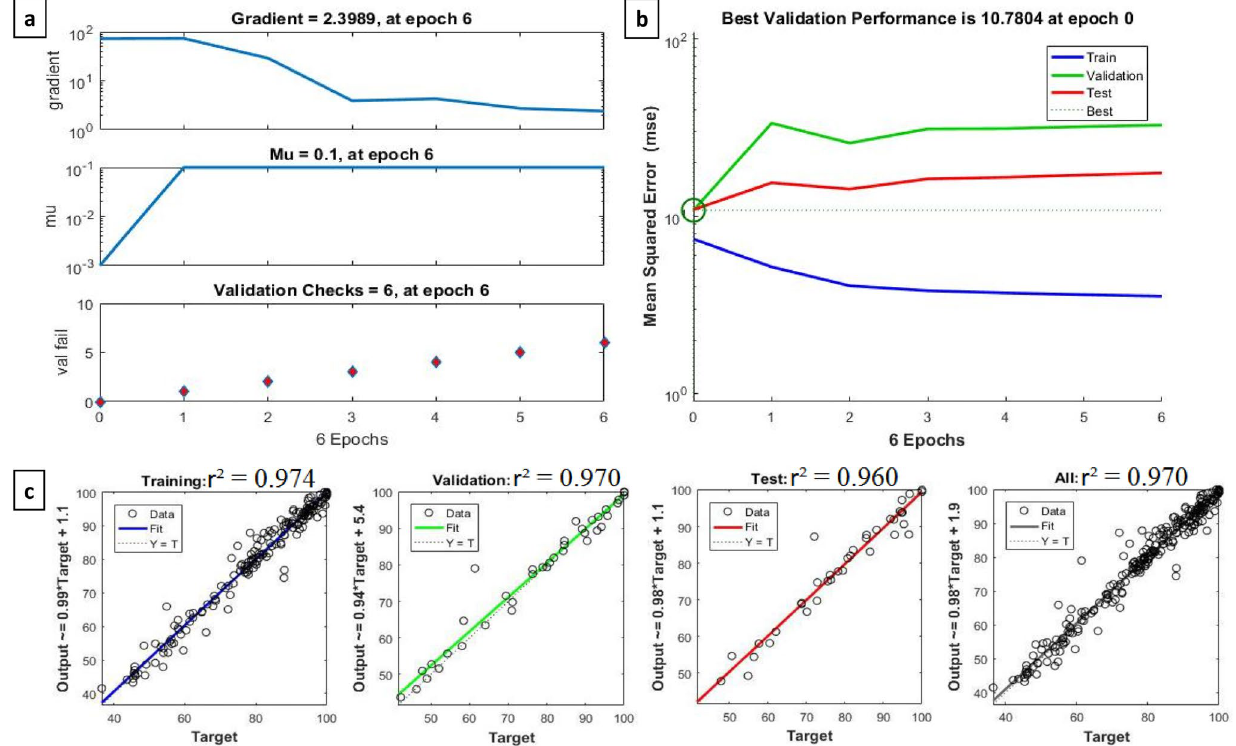
Fig. 10 Prediction of MB removal efficiency using ANN: a training performance, b best validation performance, and c regression plot between target and